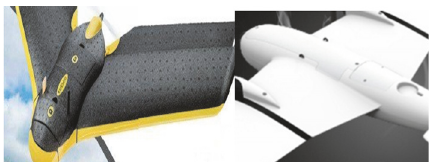
Figure 14: Structure of UAV antenna based on glass reinforced plastic